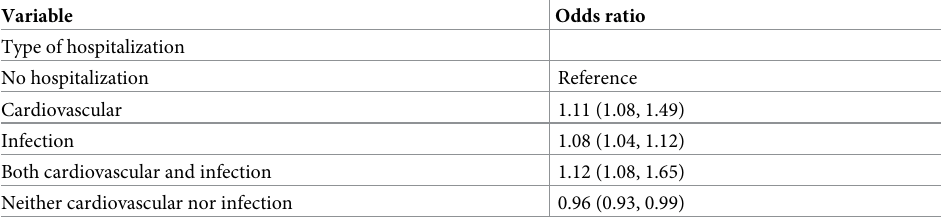
Table 3. Association between inpatient dialysis initiation and pre-ESRD